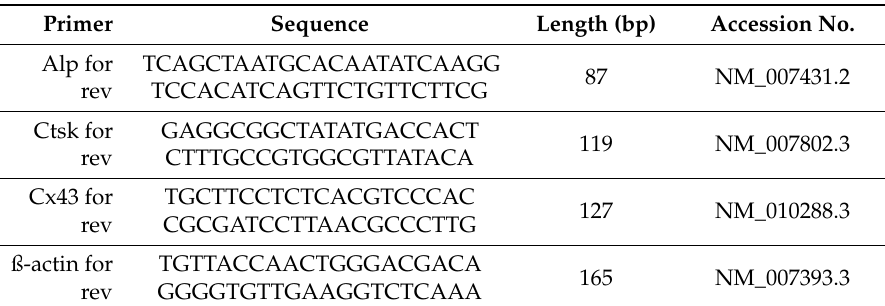
Table 1. Mouse primers used for mRNA analysis by real-time